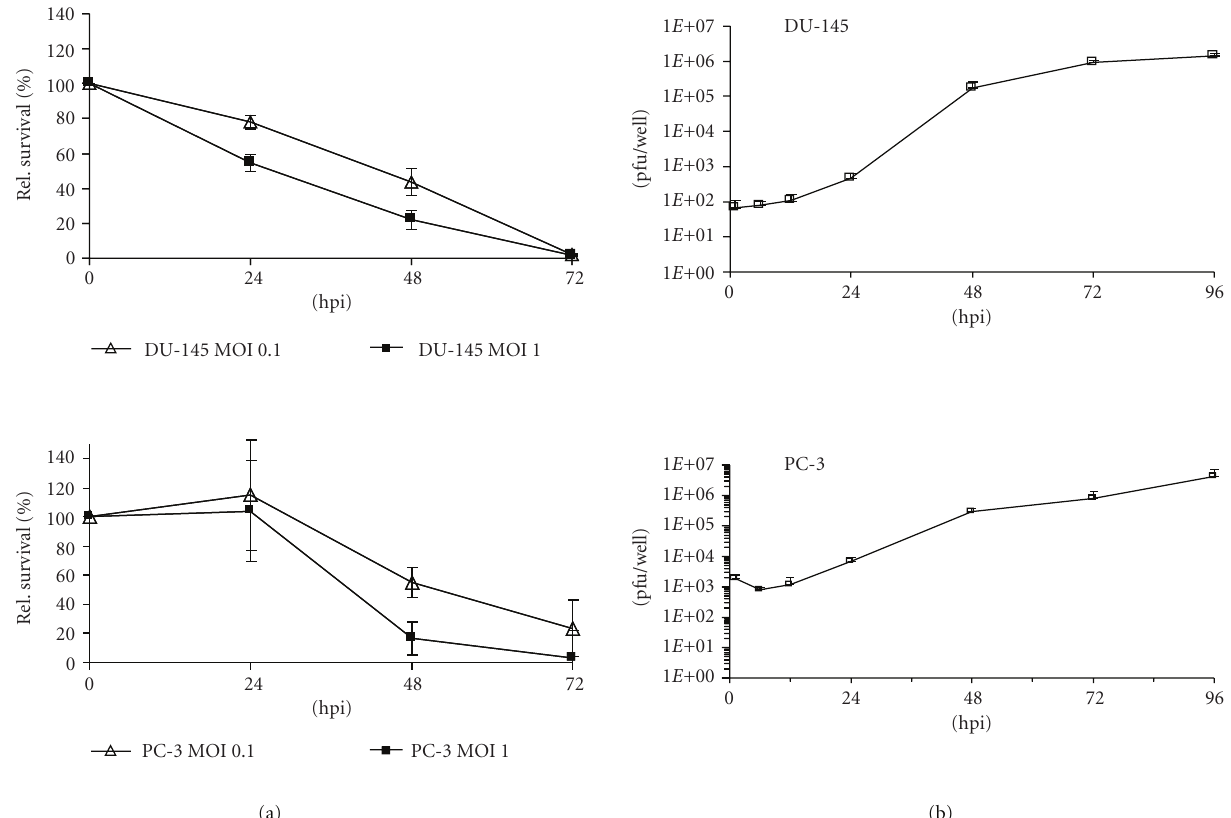
Figure 1: Cytotoxicity (a) and replication (b) of GLV-1h68 virus in human prostate DU-145 and PC-3 cells. (a) Viability of DU-145 and PC- 3 cells after GLV-1h68 infection at MOIs of 0.1 and 1, respectively, monitored over 72 hours. Values are shown as percentages of respective uninfected controls. (b) Viral titer analysis in DU-145 and PC-3 cell cultures after infection with GLV-1h68 at an MOI of 0.1. Supernatants were collected from virally treated cells at various time points postinfection (hpi). Viral titers were determined as pfu per well in triplicate by plaque assay in CV-1 cell monolayers. Average plus standard deviation are